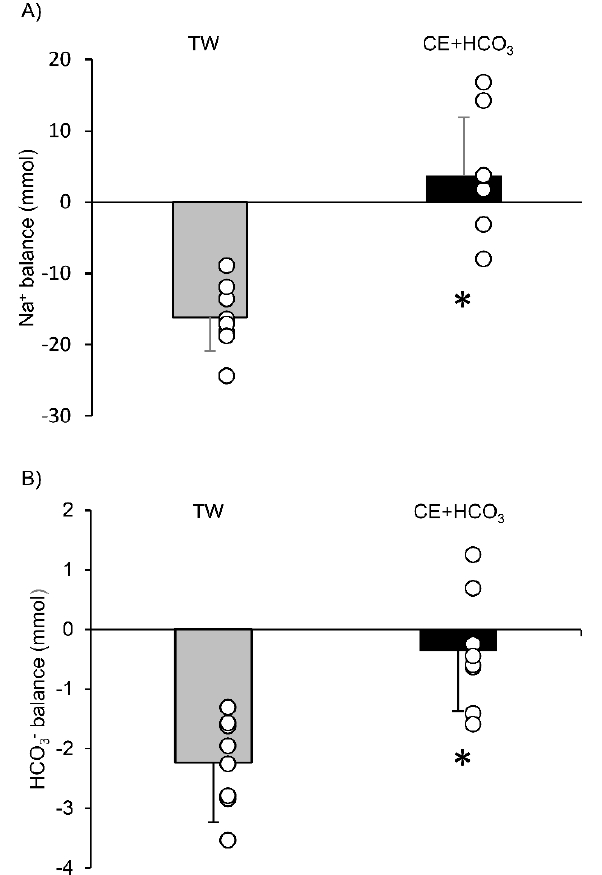
Figure 4. Mean values with SD (bar graph) and an individual data (white circles) of urine Na + ( A ) and HCO 3 − ( B ) balance at the hut between the groups are shown. Gray bars indicate the TW and black bars indicate the CE group. * indicates significant differences between the TW and CE+HCO 3 groups.